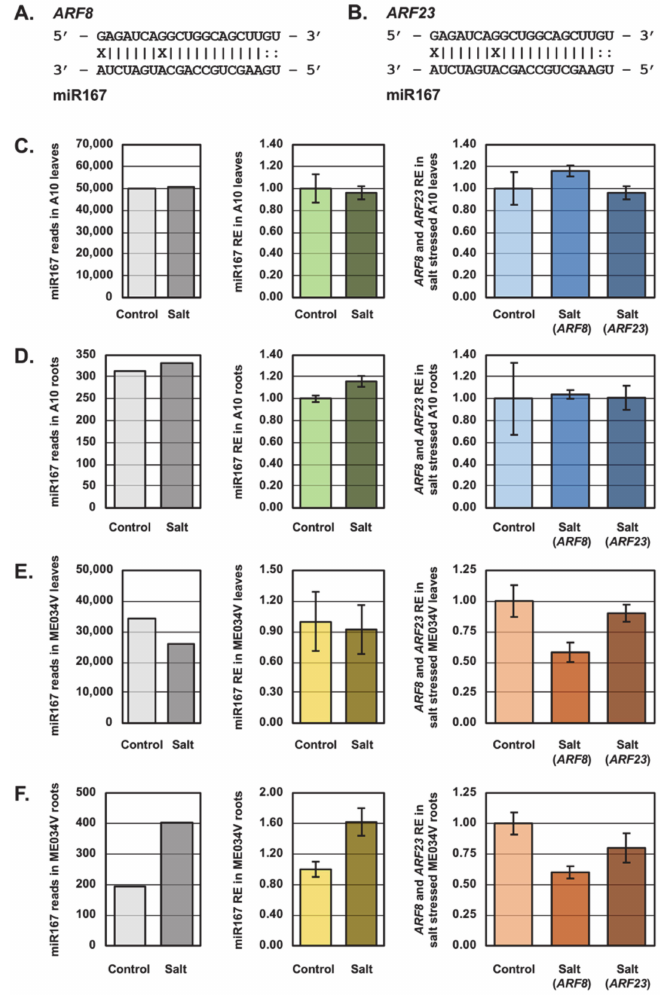
Figure 6. Molecular assessment of the response of the miR167 regulatory module to salt stress. Alignment of the S. viridis miR167 sRNA sequence to the putative target sequences harbored by the S. viridis ARF8 ( A ) and ARF23 ( B ) transcripts. Experimental validation of miR167 sRNA abundance and RT-qPCR assessment of ARF8 and ARF23 putative target gene expression in A10 shoots ( C ) and roots ( D ) post exposure of 10-day-old seedlings to salt stress. RT-qPCR confirmation of the abundance of